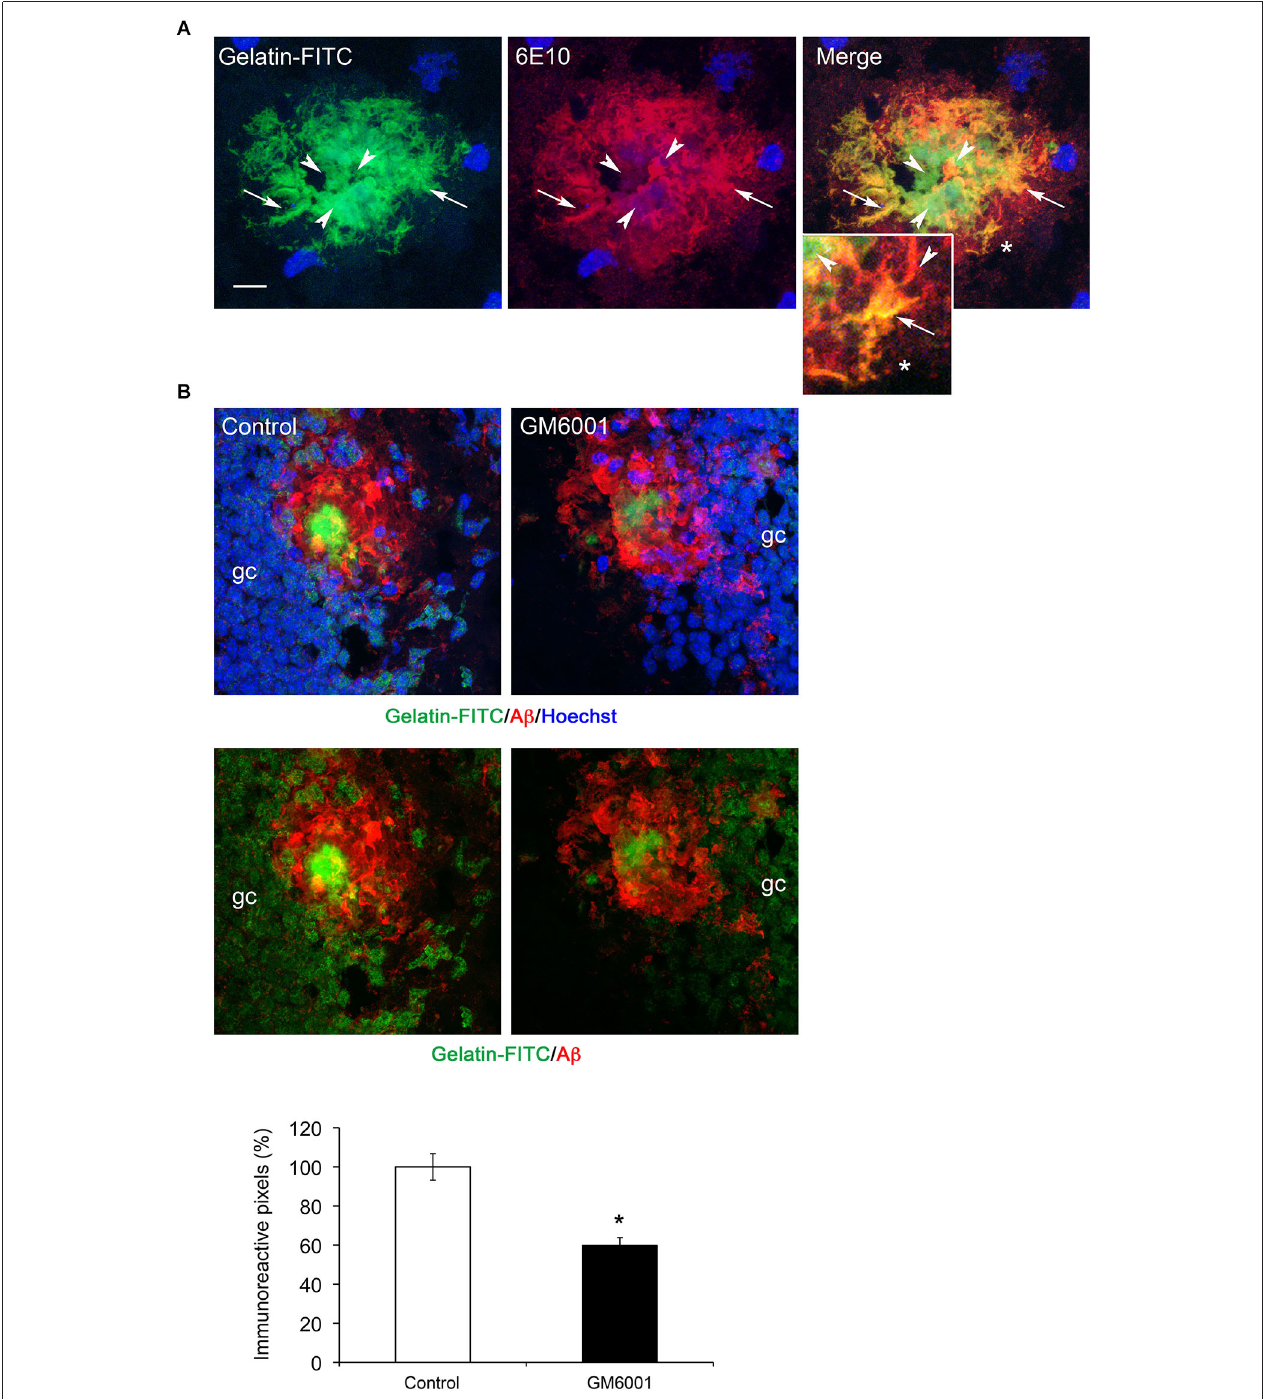
FIGURE 6 | MMP gelatinolytic activity is present in amyloid plaques. (A) Confocal microphotographs representative of four animals per group showing combined immunohistochemistry using the A β specific 6E10 antibody (red) and gelatin-FITC in situ zymography (green) in the hippocampus of 6-month-old 5xFAD mouse. Note that zones of perfect colocalization (arrows, yellow color) coexist with zones of poor or non-colocalization (arrowheads), often associated with dense core amyloid.